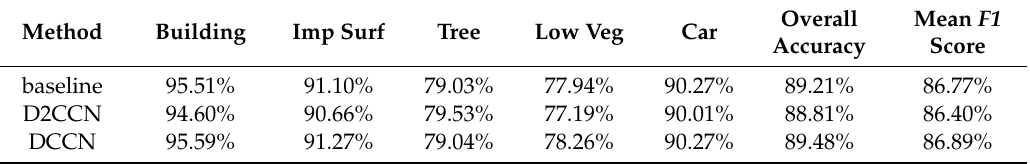
Table 8 . The kappa coefficient results of the baseline, D2CCN, and DCCN